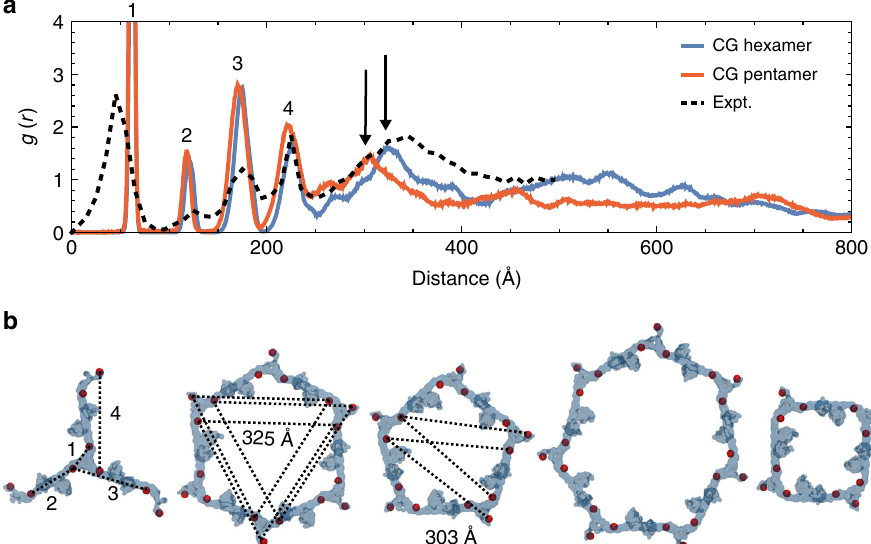
Fig. 5 Non-hexagonal defect structures of TRIM5 α lattices. a Pair correlation functions, g ( r ), between the virtual sites ’ center-of-geometry as a function of the radial distance (Å), calculated for TRIM5 α subunits that form hexagonal ordered lattices (blue) and pentagonal ordered lattices (red) on the capsid. The black dashed lines indicate the g ( r ) calculated from models derived from experimental cryo-ET densities (see Fig. 4). Peaks 1 – 4 are labeled. Arrows indicate close-range differences in the lattice spacing peaks between hexagonal and pentagonal lattices. b Higher-ordered TRIM5 α structures that spontaneously assemble on the capsid during simulation. TRIM5 α subunits are colored in transparent blue, and the center-of-geometry for the virtual sites is depicted as red spheres. Dotted lines indicate intermolecular distances that form peaks in the pair correlation function, g ( r ). Source data are provided as a Source Data fi le.